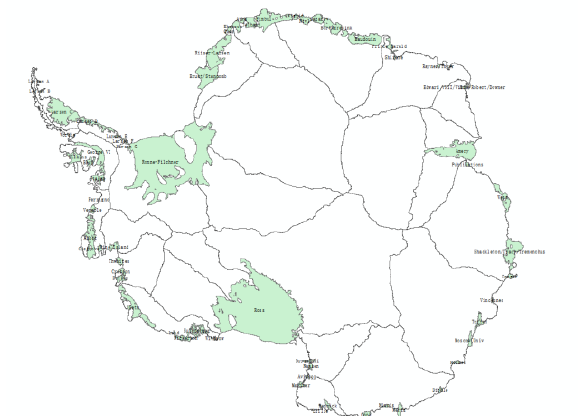
Figure 1. Location and name of ice shelves that are analyzed motion rate.